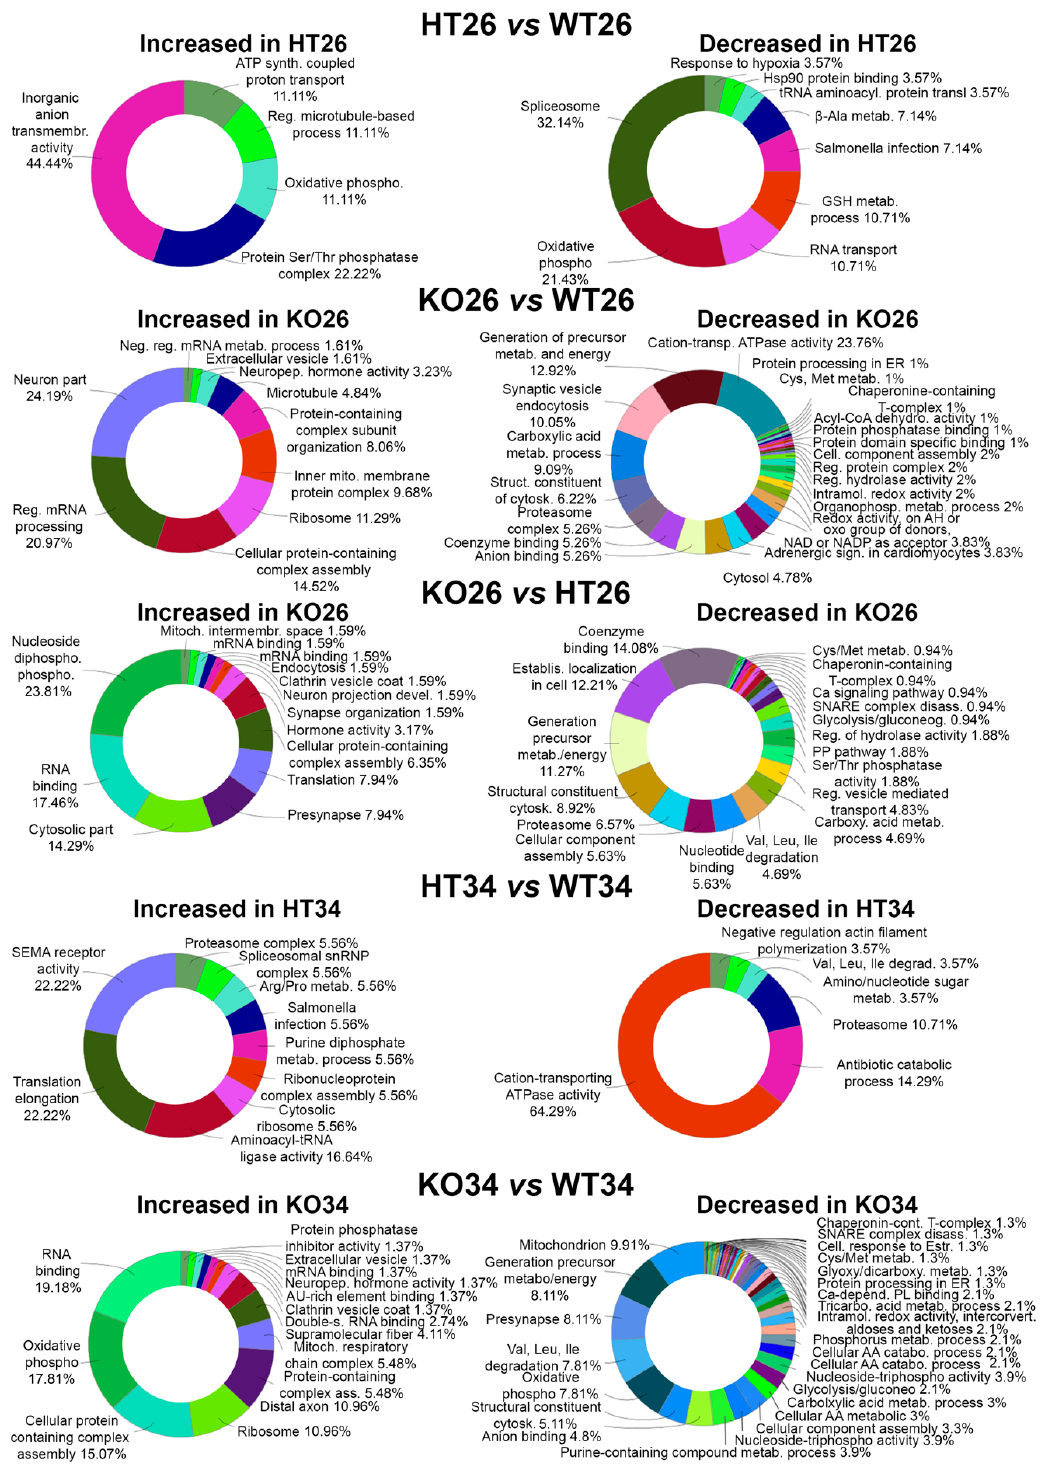
Figure 3. Bioinformatic analysis by ClueGo of the proteins differentially or exclusively expressed in HT26 vs. WT26, KO26 vs. WT26, KO26 vs. HT26, HT34 vs. WT34, KO34 vs. WT34. Bioinformatic analyses were carried out by ClueGo software (Cytoskape release 3.8.2) to cluster enriched annotation groups of biological processes, pathways, and networks within the set of differentially expressed or exclusively expressed proteins in the comparisons. Functional grouping was based on p ≤ 0.05. Functional grouping was based on p ≤ 0.05 and at least three counts.